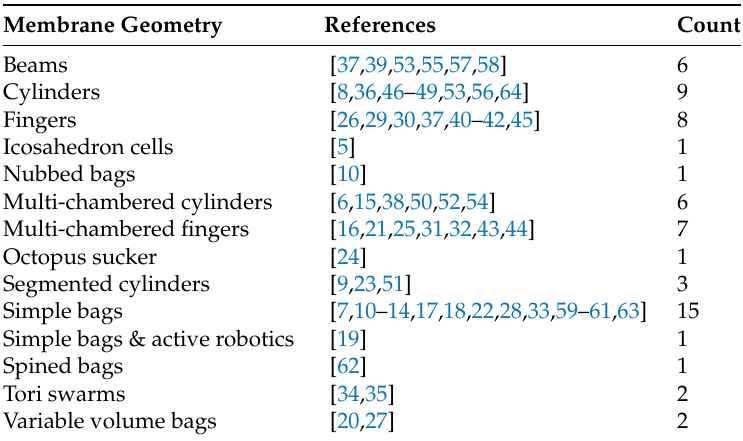
Table 6. Frequency of use of jamming actuator